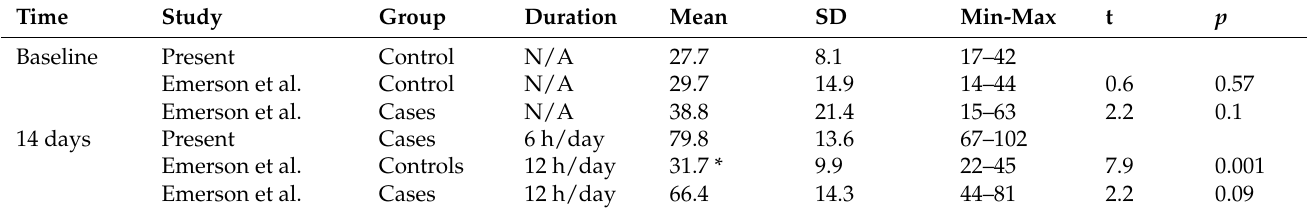
Table 2. Rabbit 25-OHD3 (nmol/L) concentrations in juvenile domestic rabbits ( n = 6) at baseline and 14 days later after 6 h/day artificial UVB exposure compared with rabbits exposed to the same artificial lights (irradiance) at baseline (controls, n = 6; cases, n = 6) and 14 days (controls, n = 4; cases, n = 5) [3] after 12 h/day